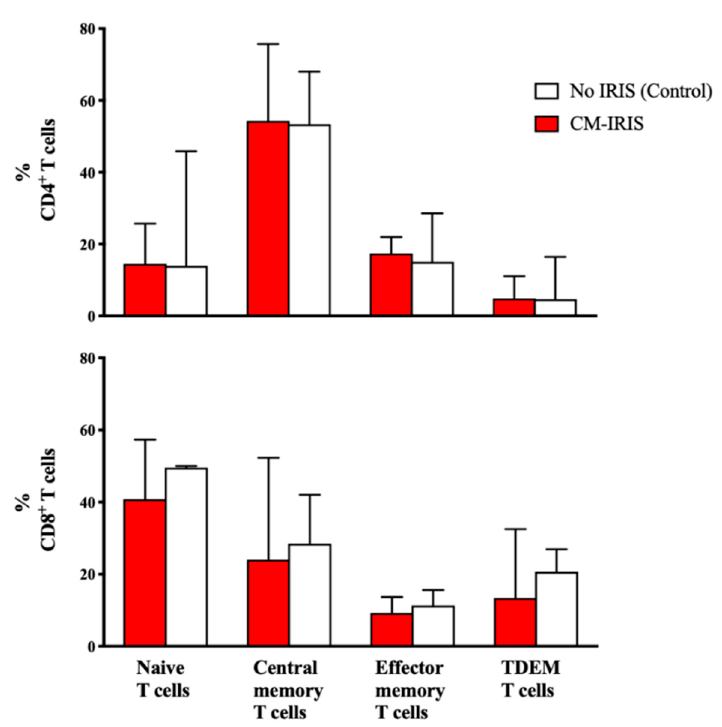
Figure 2. Frequencies of CD4 + and CD8 + memory T cell subsets at the time of initial cryptococcal meningitis diagnosis among ART-naïve subjects who later developed CM-IRIS vs. controls without IRIS. CD4 + Central memory and CD8 + naïve T cells predominated without significant differences between groups. Bars represent median values and error bars show interquartile ranges. Abbreviations: TDEM- terminally differentiated effector memory. White bars represent CM diagnosis, red bars represent CM-IRIS.